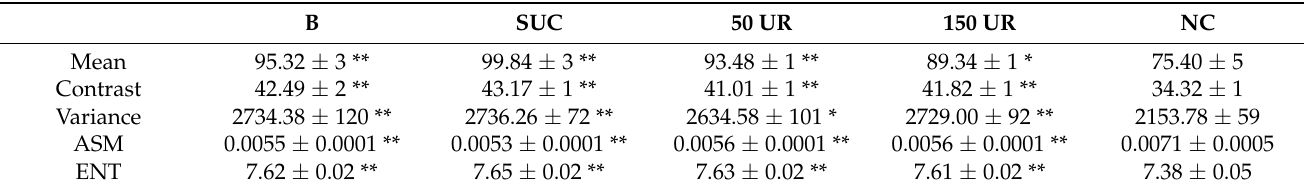
Table 2. Statistical analysis table of texture analysis on day 14.